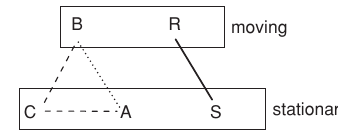
Figure 2 Coordinate